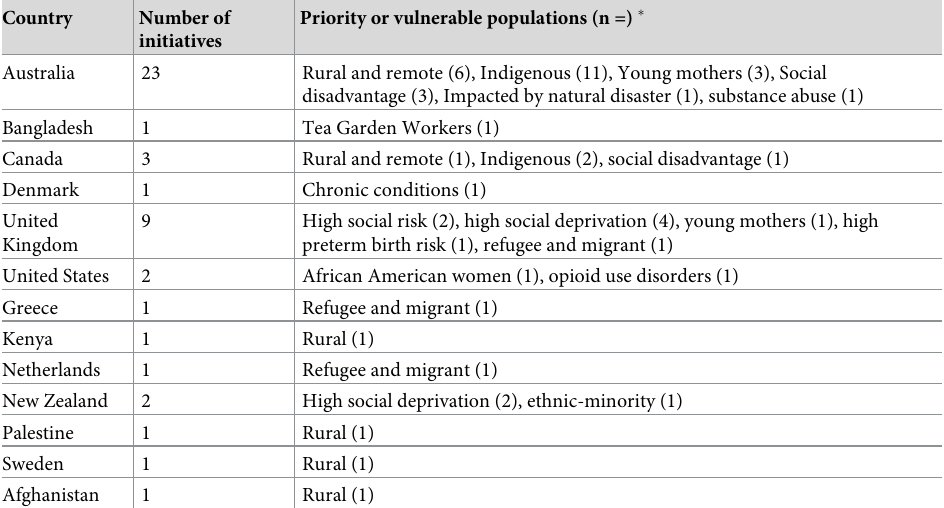
Table 3. Initiatives for women, newborns and families with risk of adverse outcomes by country.